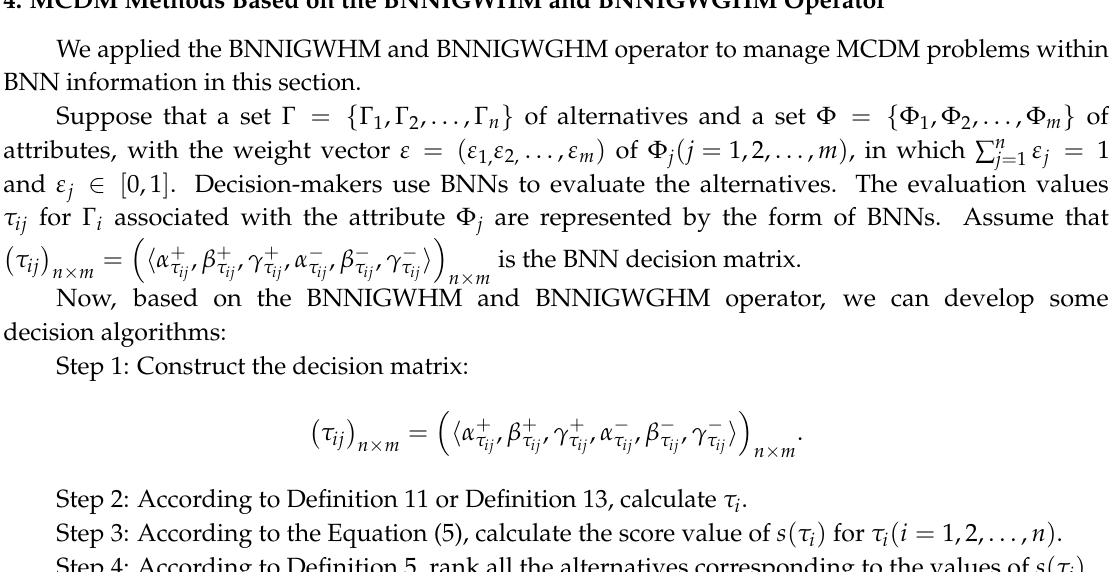
Table 1. The decision matrix ( τ ij )